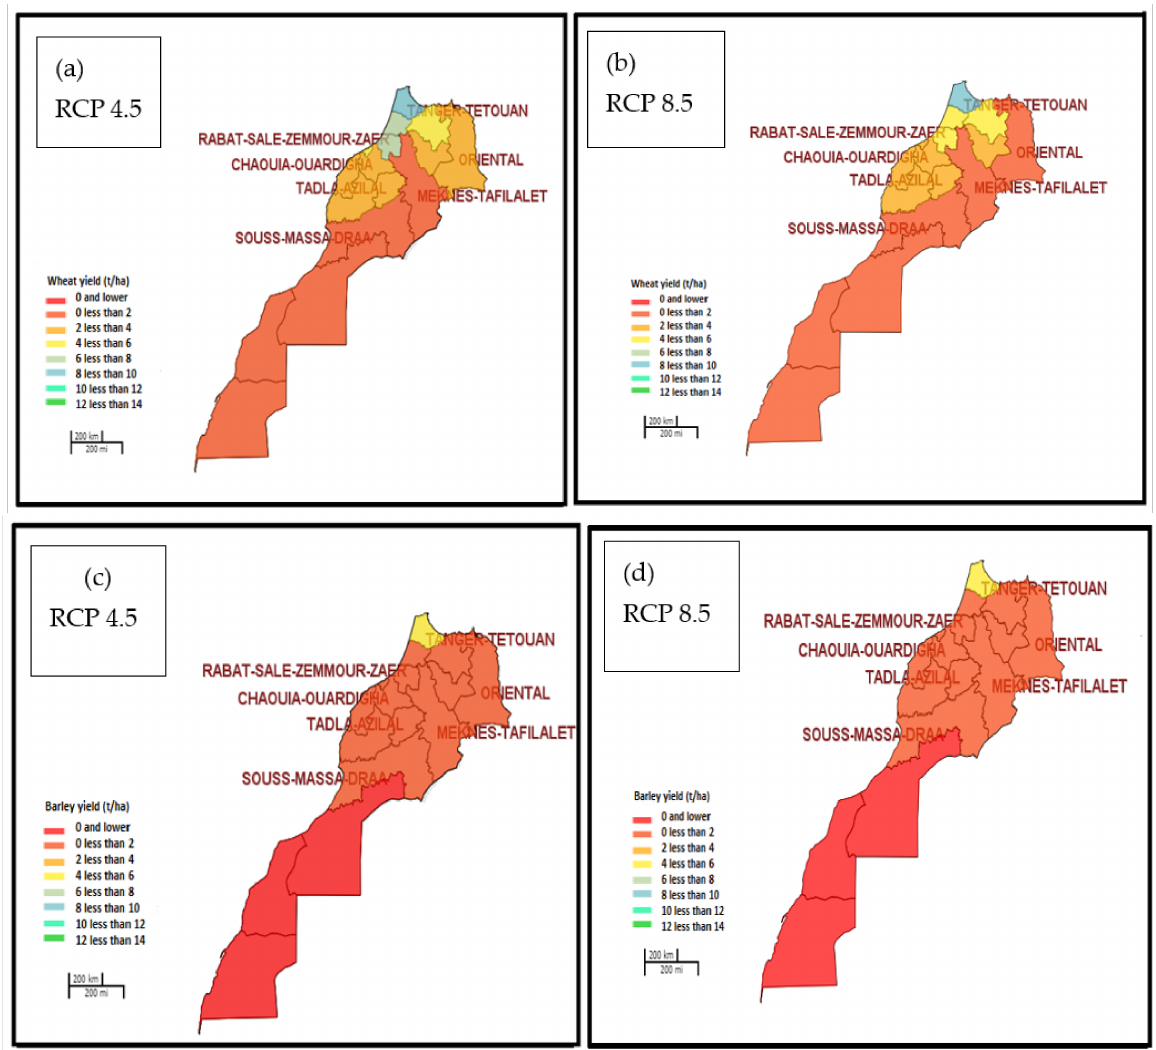
Figure 8. Spatial distribution of crop yields across Morocco under different scenarios for ( a ) wheat at